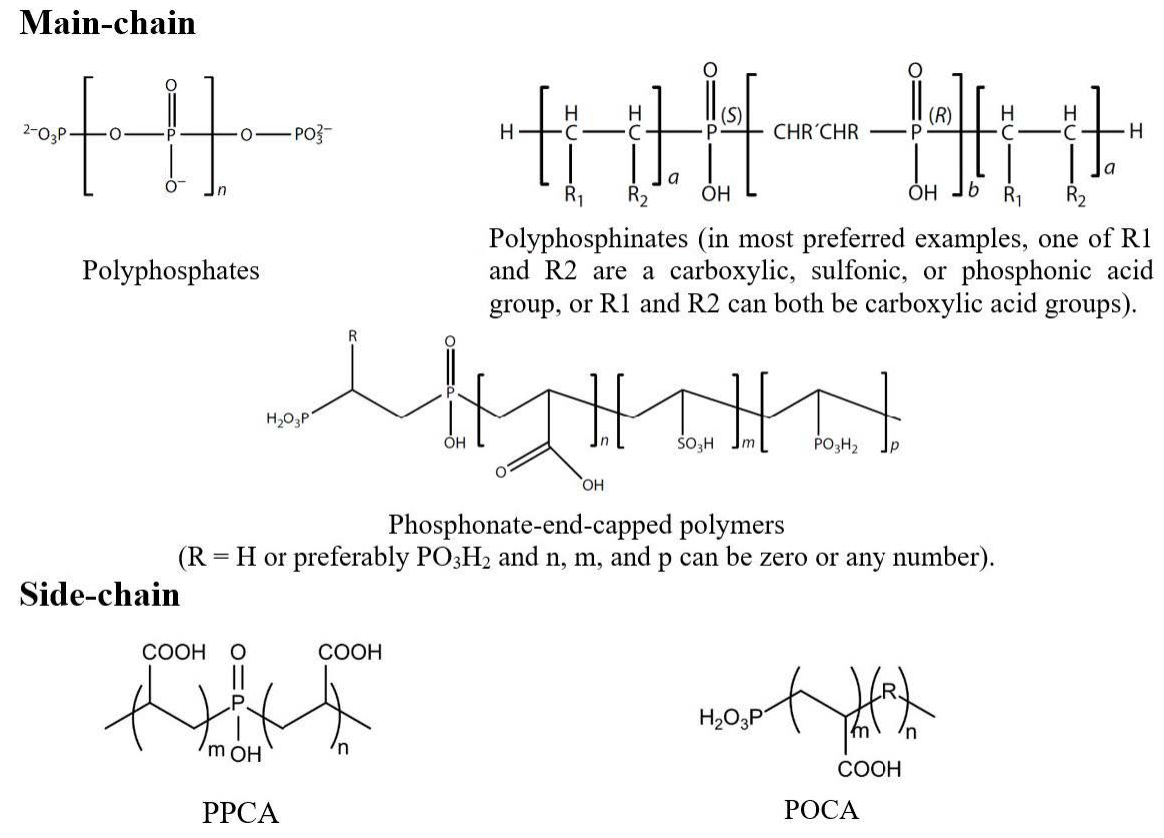
Figure 3. Structures of typical phosphorus-containing polymers.